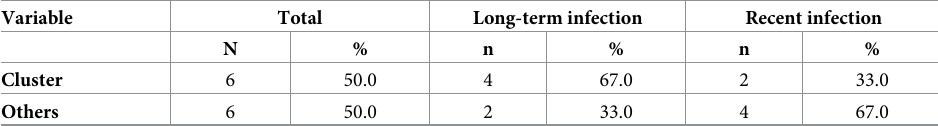
Table 2. The HIV status of 12 propofol injectors.